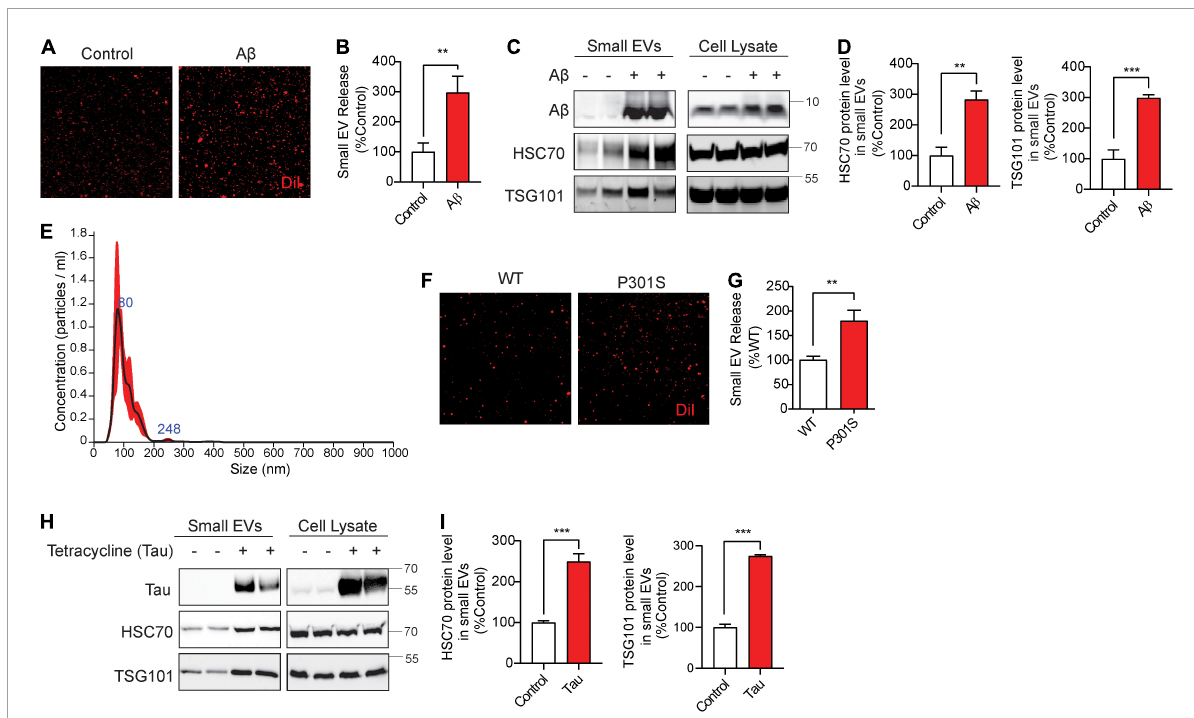
FIGURE5 A β 42 oligomers (A β 42) oligomers and misfolded tau increase small EV secretion and are associated with secreted small EVs. (A) Representative images of DiI-stained small EVs secreted from HT22 cells with or without 250 nM A β treatment for 24 h. (B) Quantification of secreted small EVs for (A) . Data are presented as means ± SEM. n = 3 independent experiments, t -test, ** P < 0.005. (C) Representative immunoblots for the indicated proteins in secreted small EVs and cell lysates from HT22 cells with or without 250 nM A β treatment for 24 h. (D) Quantification of Hsc70 and TSG101 (small EV markers) for (C) . Data are presented as means ± SEM. n = 4 independent experiments, t -test, *** P = 0.0007, ** P < 0.004. (E) Representative NTA analysis of vesicle size distribution of small EVs isolated from HT22 cells. The black line indicates concentration and size of particles, and the red line indicates standard error. (F) Representative images of DiI-stained small EVs secreted by DIV10 cortical primary neurons derived from C57BL6 (WT) or tau P 301 S (P301S) mice. (G) Quantification of secreted small EVs for (F) . Data are presented as means ± SEM. n = 3 independent experiments, t -test, ** P = 0.002. (H) Representative immunoblots for the indicated proteins in secreted small EVs and cell lysates from tet-inducible iHEK-P301L cells expressing tau P 301 L , with or without tetracycline. (I) Quantification of Hsc70 and TSG101 (small EV markers) for (H) . Data are presented as means ± SEM. n = 4 independent experiments, t -test, *** P <